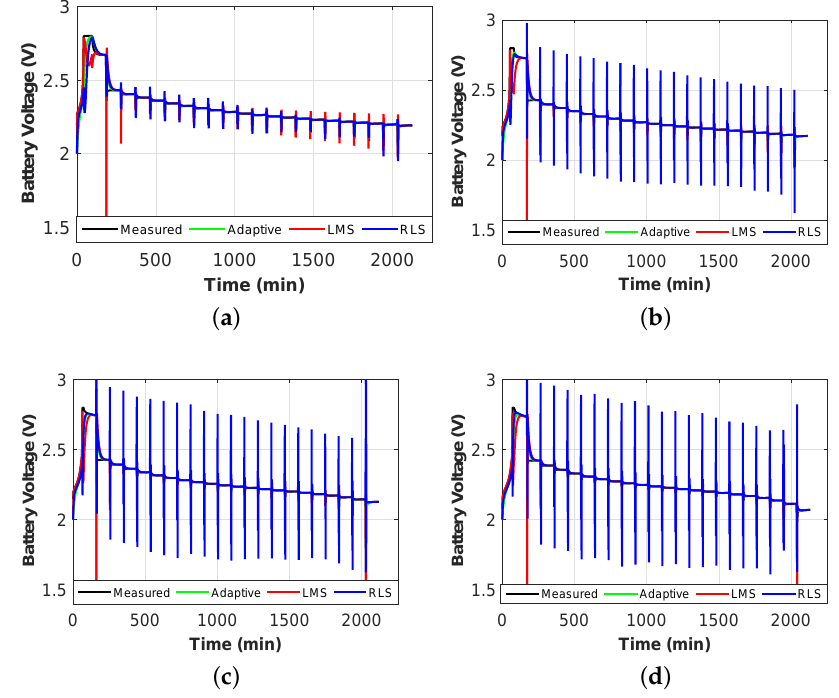
Figure 9. Battery’s voltage at different temperatures in discharge mode. ( a ) 0 ◦ C; ( b ) 10 ◦ C; ( c ) 25 ◦ C; and ( d ) 40 ◦ C.